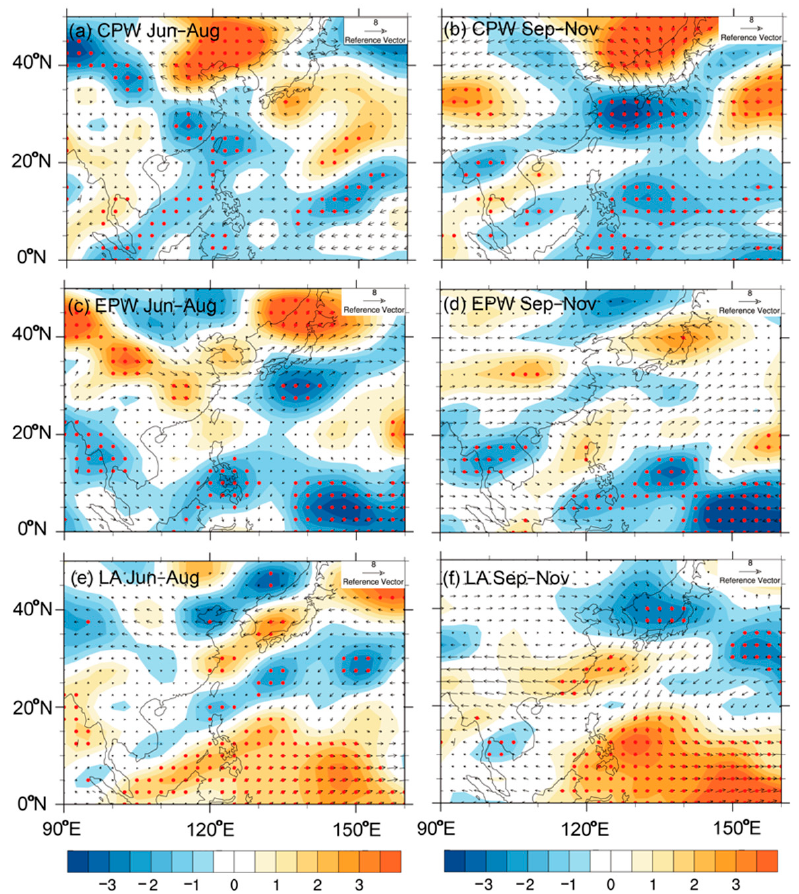
Figure 12. Composite anomalies of the divergence (shaded, 10 − 6 s − 1 ) and wind vector (vector, m/s) at 200 hPa for JJA ( a , c , e ) and SON ( b , d , f ) seasons during CPW ( a , b ), EPW ( c , d ) and LA ( e , f ) events. Regions with trends that are significant at 90% confidence are shaded by red dots.